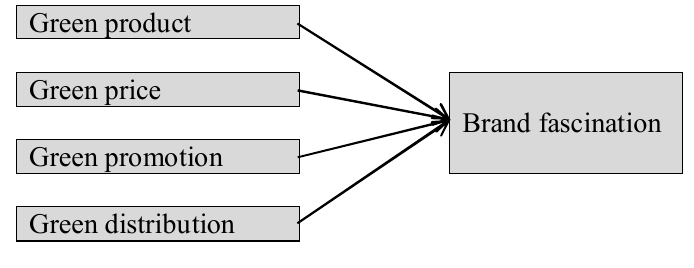
Fig. 1. The proposed